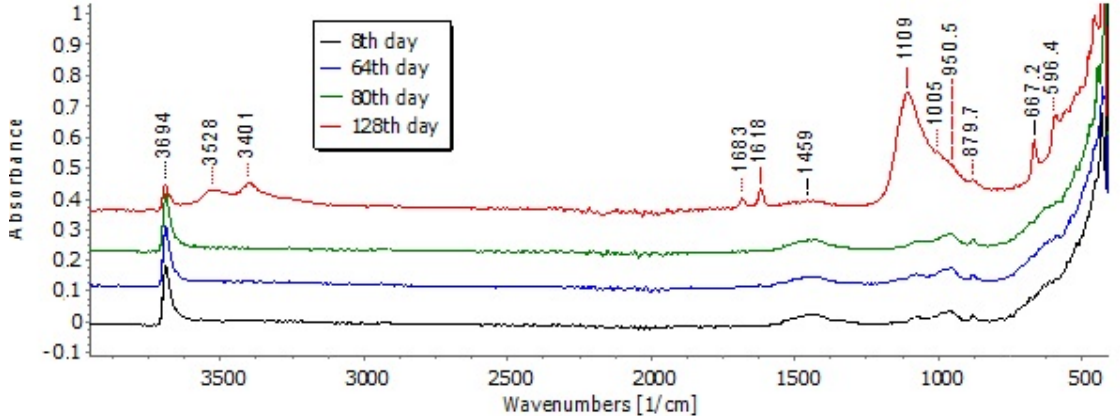
Figure 14. The evolution of ATR spectra of selected samples at 8, 64, 80 and 128 days during the long-term spraying test.